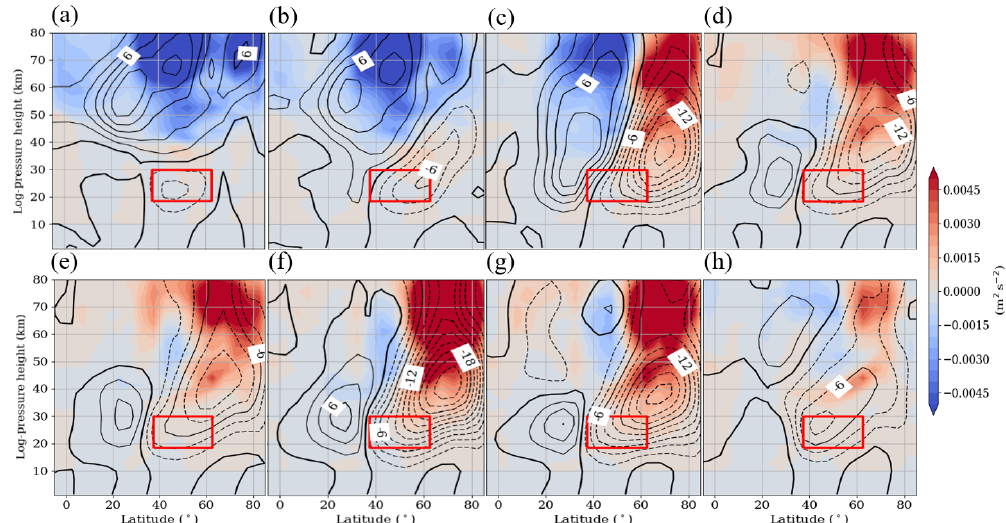
Figure 3. Zonal-mean zonal wind (contour lines) and GW momentum flux (color coding) differences between the H1–H8 (a–h) and the Ref simulation. The last 30 model days are analyzed. Zonal wind differences are presented in intervals of 2ms − 1 . The dashed (solid) lines represent negative (positive) differences. The zero line is highlighted. The position of the GW hotspots is shown by the red box.